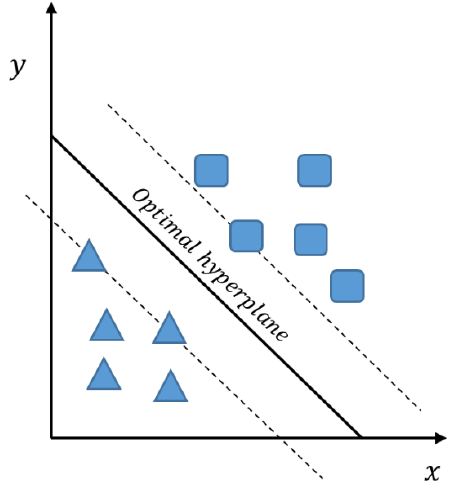
Figure 4. SVM optimal hyperplane.